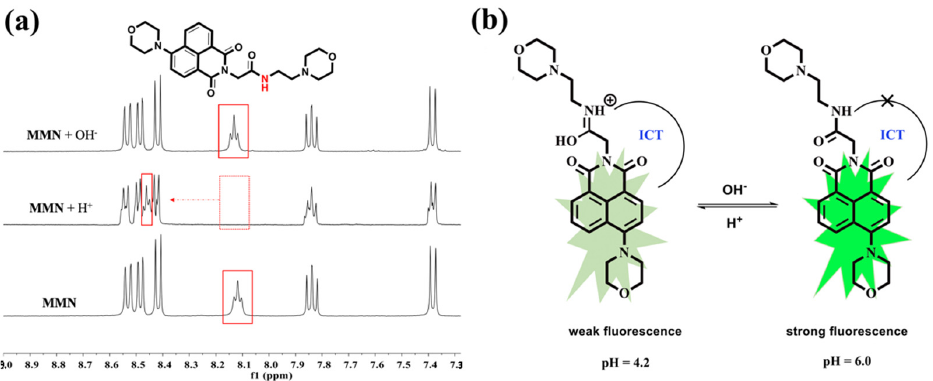
Figure 3. ( a ) The 1 H NMR spectra of probe MMN , MMN + H + and MMN + OH − in D 2 O/DMSO- d 6 ( v/v , 1:1). ( b ) Proposed sensing mechanism of MMN toward H + .